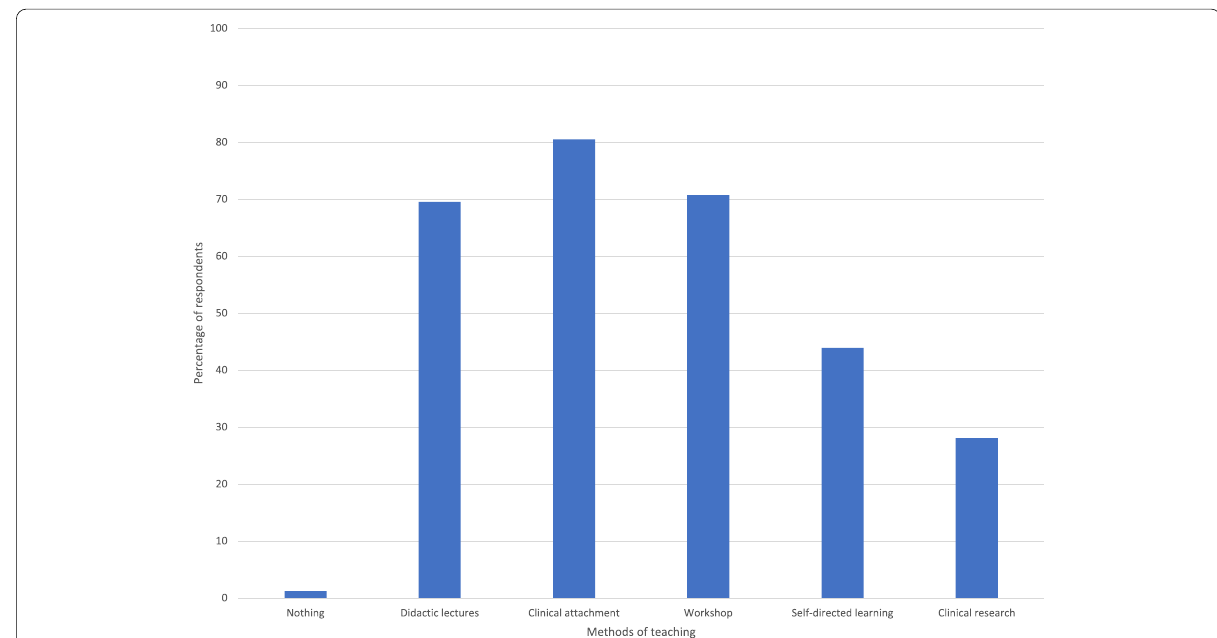
Fig. 5 Bar graph showing ways students suggest interventional radiology teaching could be improved in medical